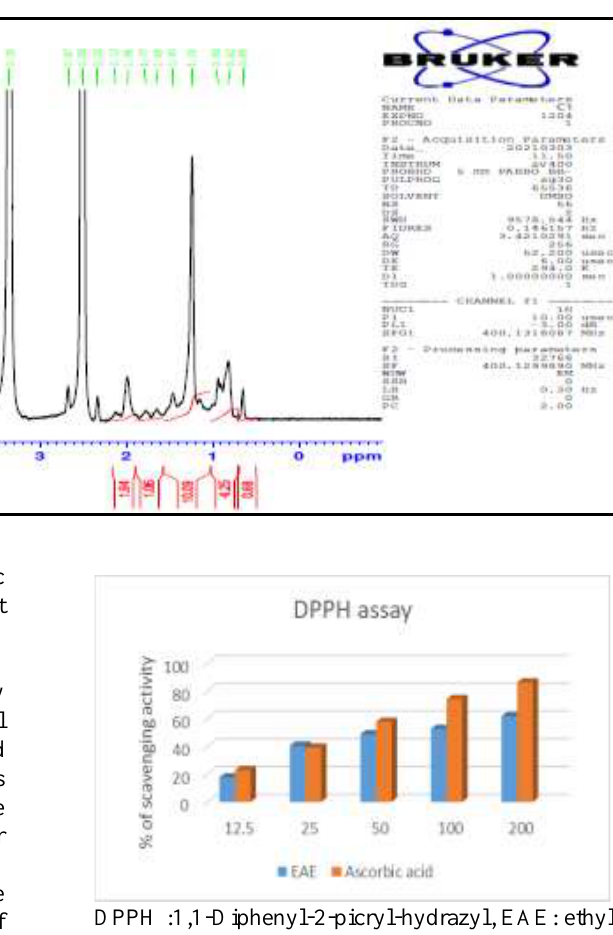
Figure 6.The antioxidant activity of EAE measured by DPPH method and compared with ascorbic acid standard: (EAE) ethyl acetate extract of Iraqi C.grandiflora ,(DPPHassay)1,1- Diphenyl-2-picryl-hydrazyl